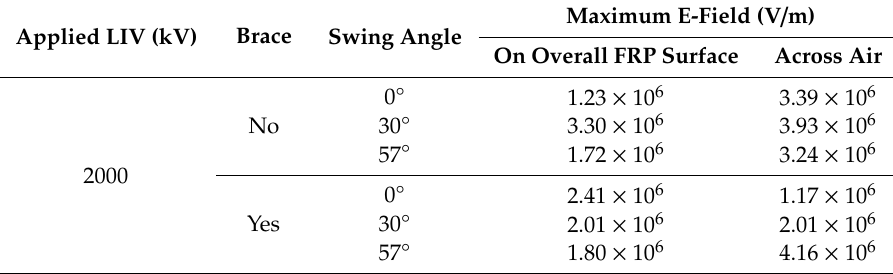
Table 5. Maximum electric field under SF